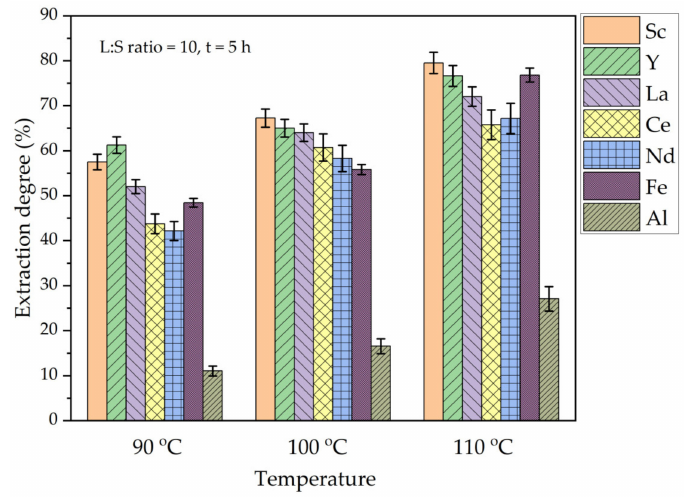
Figure 8. The effect of temperature on the extraction degree of REEs, Fe, and Al from DCFA by (NH 4 ) 2 SO 4 + H 2 SO 4